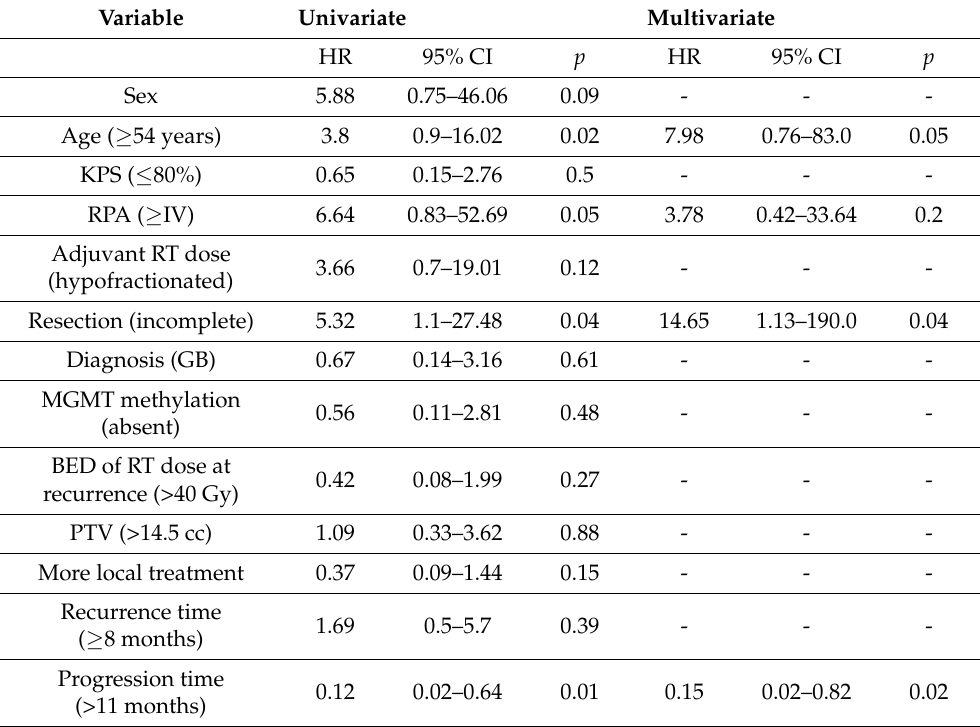
Table 3. Univariate and multivariate analysis of prognostic factor for overall